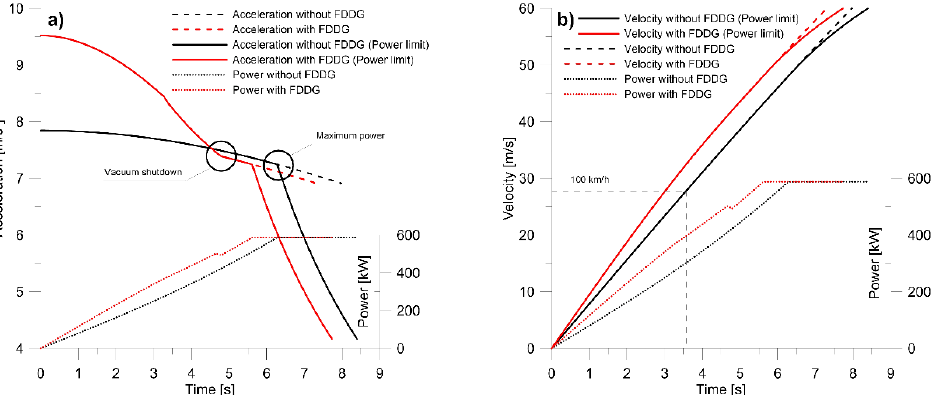
Figure 34. Comparison of car performance equipped with FDDG and without it in acceleration from a full stop: ( a ) Acceleration; ( b ) Velocity. a full stop: ( a ) Acceleration; ( b )